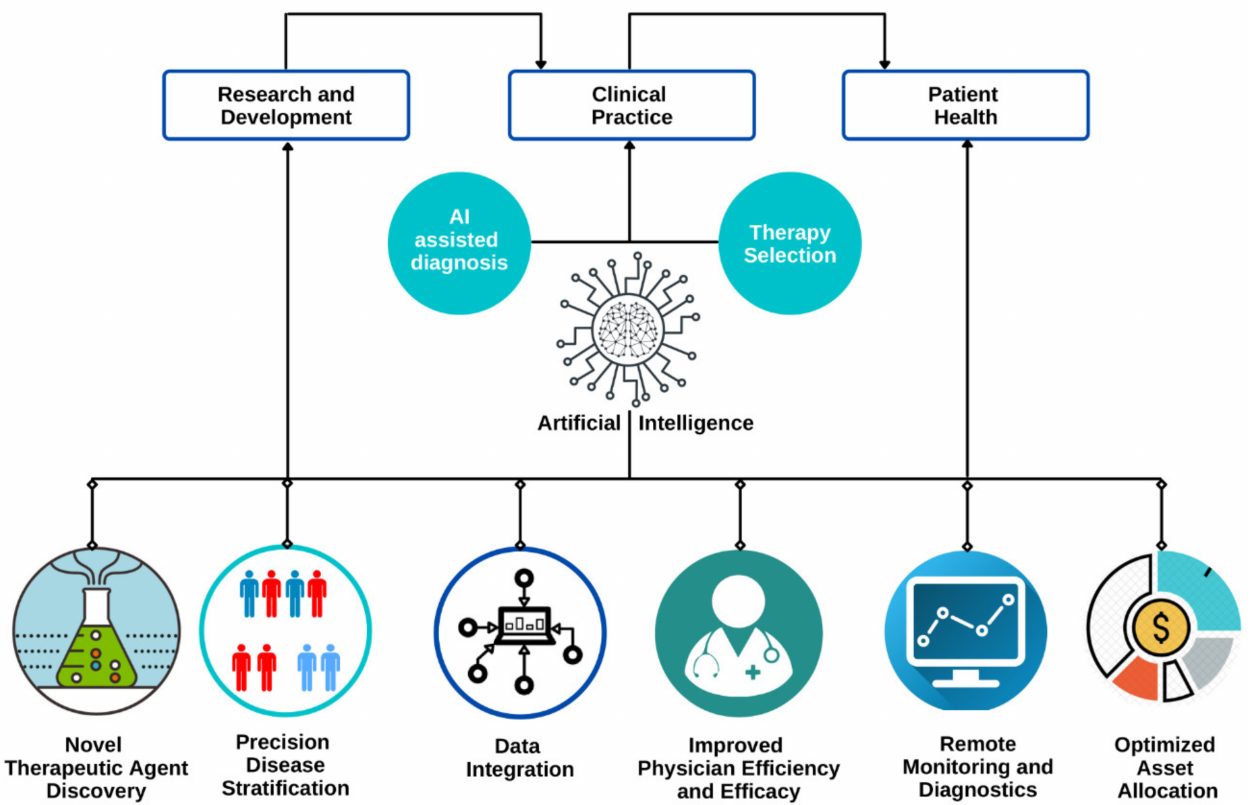
Figure 2. Role of artificial intelligence in